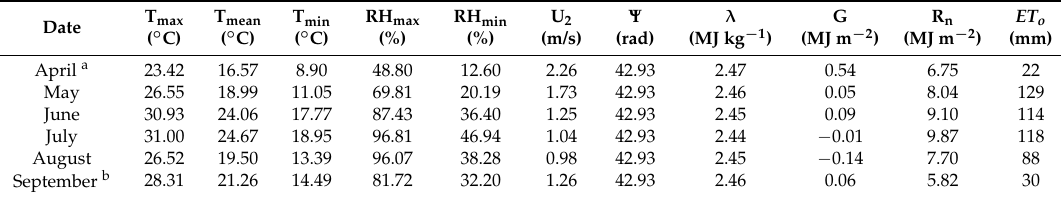
Table 4. Maximum air temperature (T max ), minimum air temperature (T min ), mean air